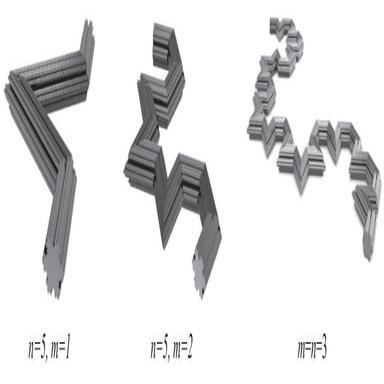
3D views of Koch fibers for different complexities.